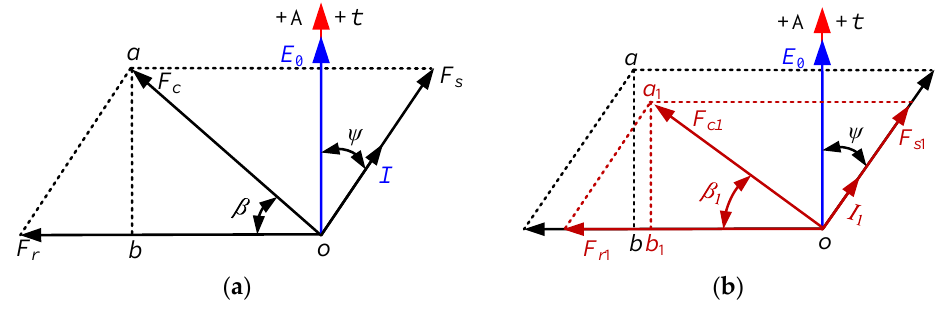
Figure 3. The MMF vector diagram: ( a ) Normal, ( b ) DSISC.